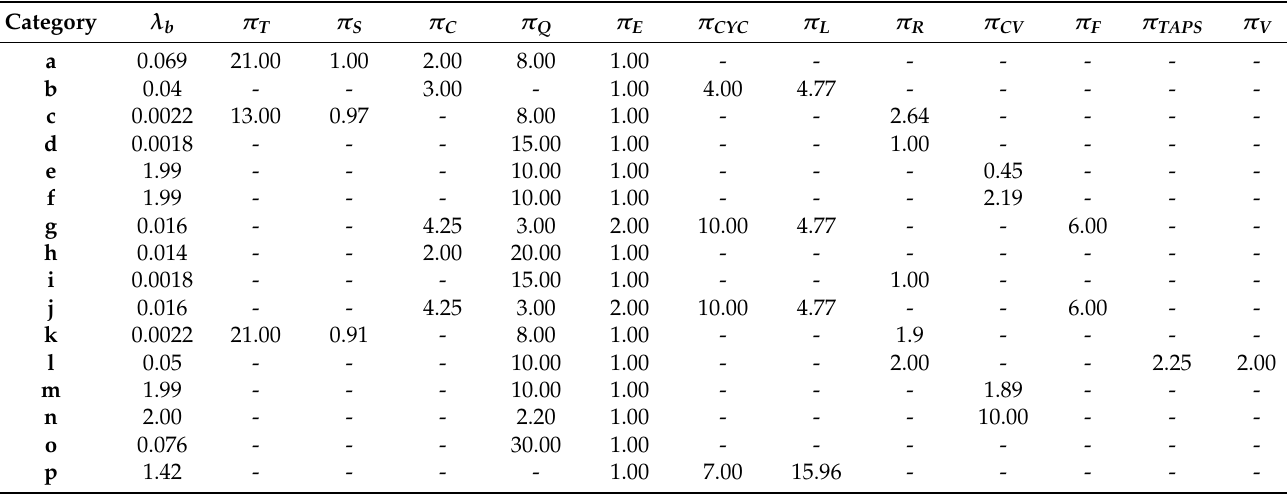
Table 3. Values of factors used for each PCB component.